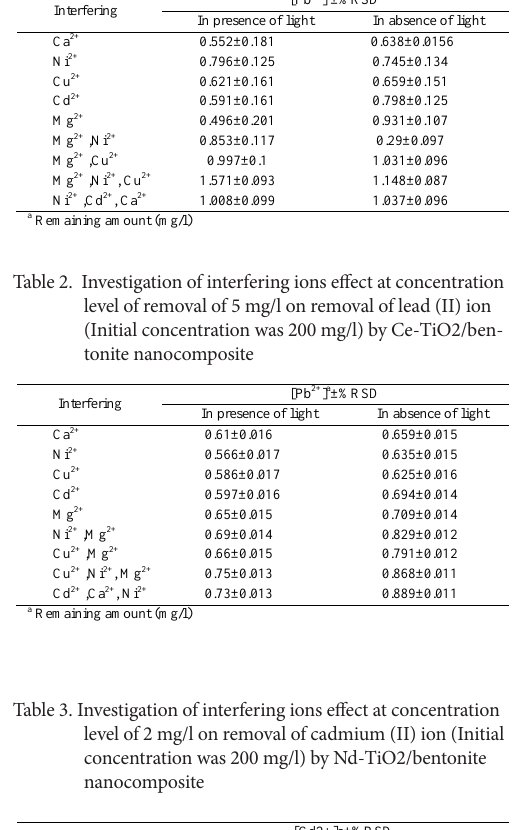
Table 1. Investigation of Interfering ions effect at concentration level of 5 mg/l on removal of lead (II) ion (Initial concentration was 200 mg/l) by Nd-TiO 2 /bentonite nanocomposite [Pb 2+ ] a ±%RSD Interfering In presence of light In absence of light Ca 2+ 0.552±0.181